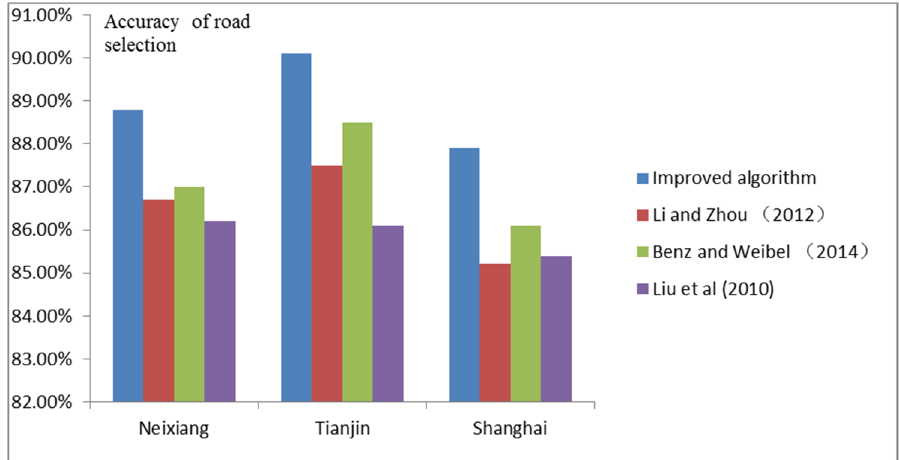
Figure 15. Accuracy of different road selection methods.